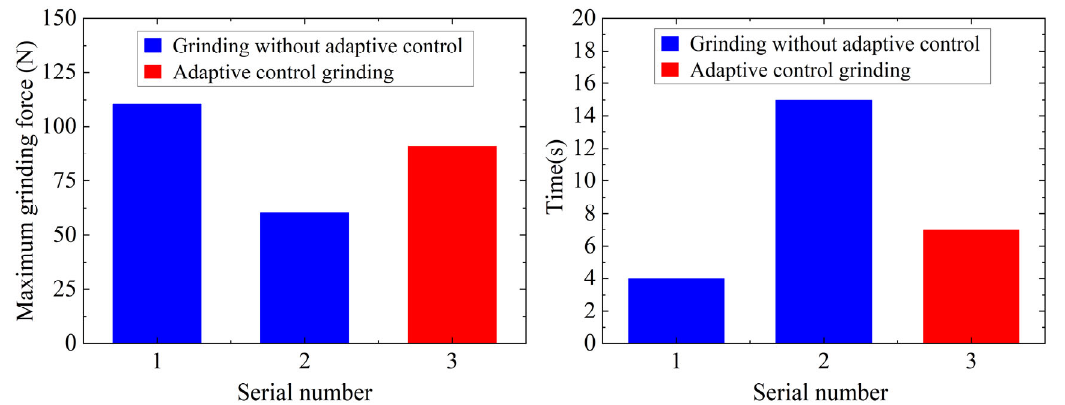
Figure 11. Comparison of experimental results.